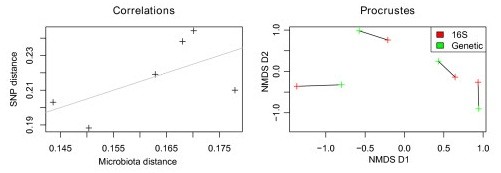
The genetic distance between mouse strains is significantly correlated to phylum level microbiota distances. A Procrustes superimposition of the NMDS of both data types shows a clear association between mouse genotypes and microbiota composition. The P-value is calculated separately with a Mantel test.